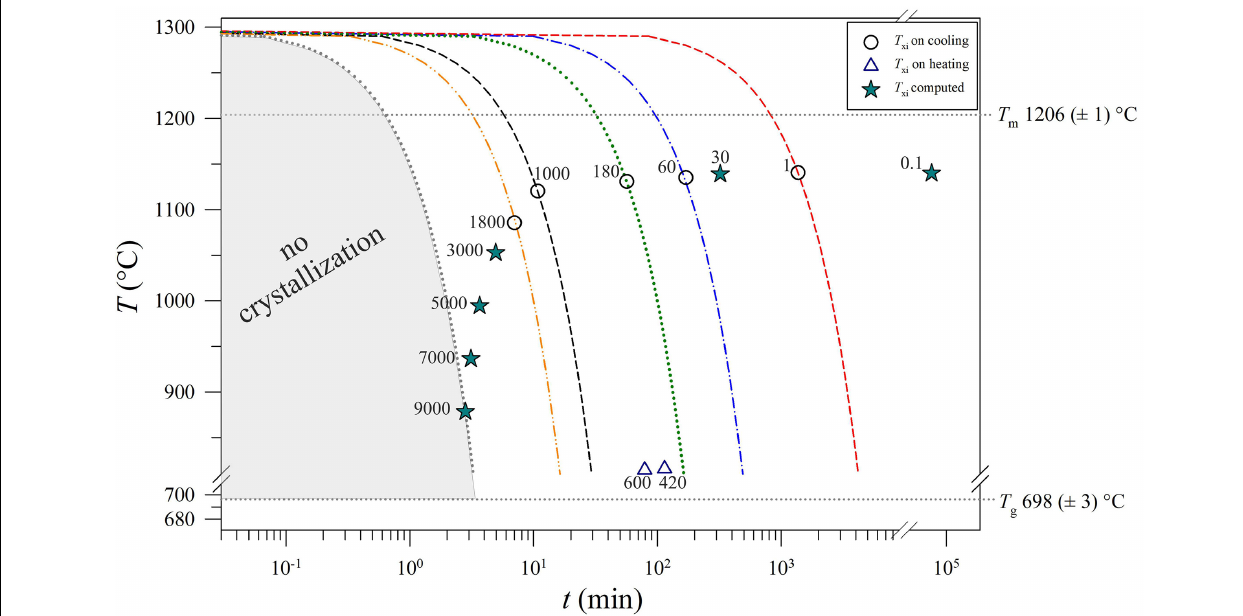
Frontiers in Earth Science |